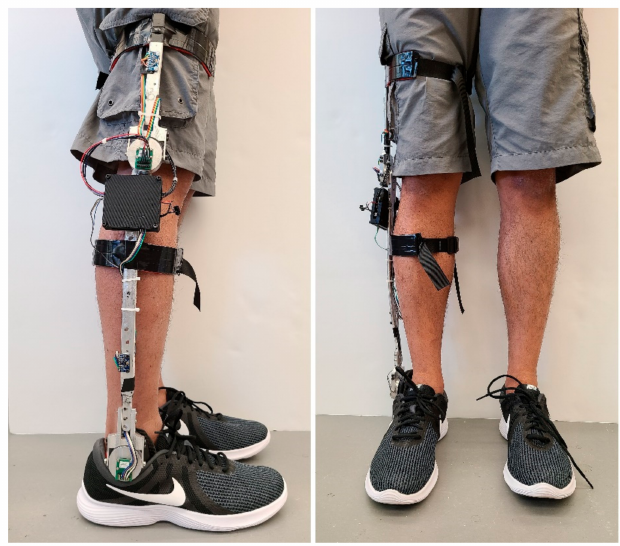
Figure 4. Prototype of the measurement